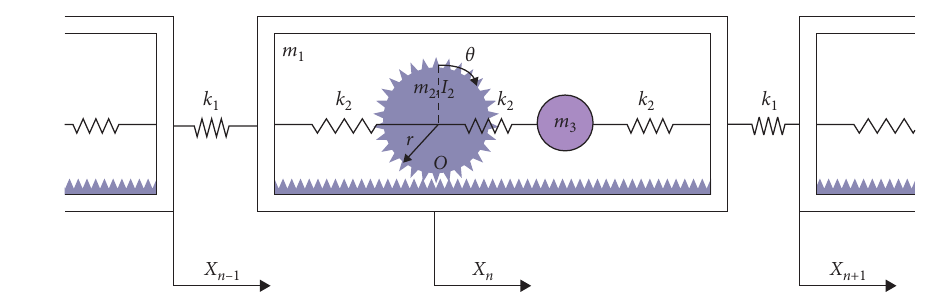
Figure 5: A schematic of a unite cell of 2DOF